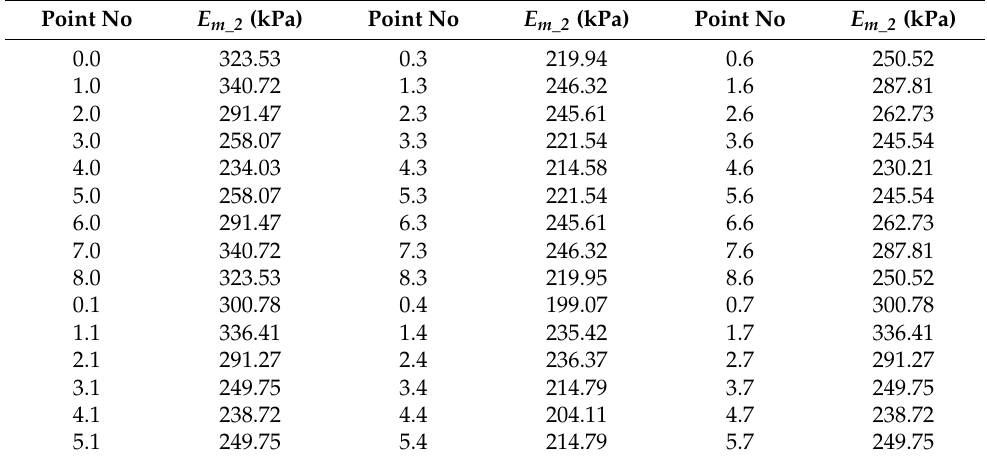
Table 4. The results of the constrained modulus of elasticity of the peat materials at the calculation points are determined by the second